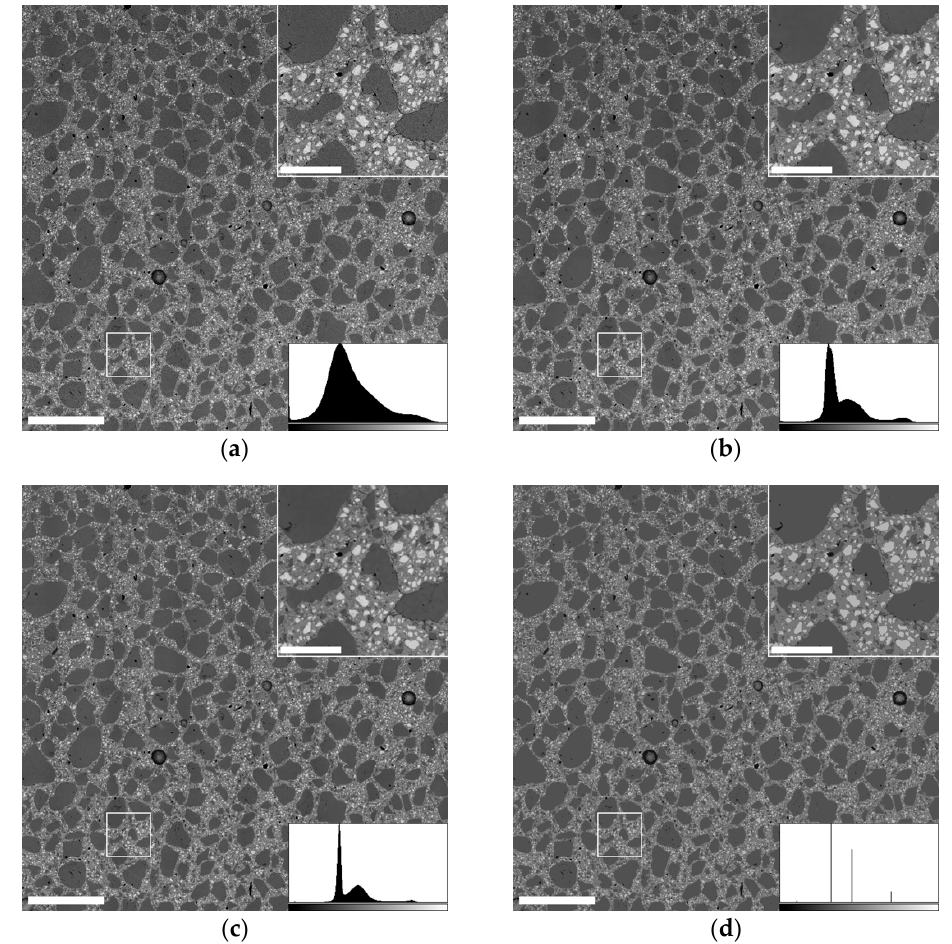
Figure 2. Steps of SEM image processing and segmentation: ( a ) Unprocessed image; ( b ) After non- local means denoising; ( c ) After band-pass filtering; ( d ) After k-means clustering segmentation. Scale bars in large-area images and higher-magnification insets are 1 mm and 200 μ m, respectively.